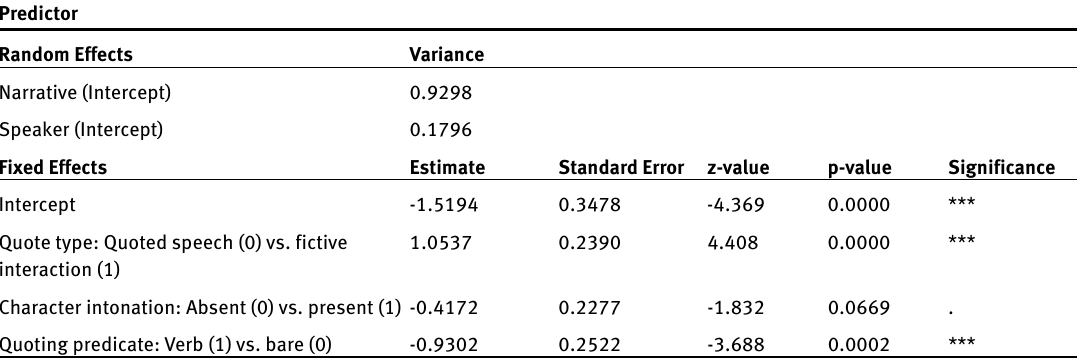
Table 9: The best generalized mixed-effects regression model for Quoted Monologues. Only predictors for the best-fit model are shown. Negative estimates indicate lower probability. Significance is indicated as follows: *** indicates p < 0.001, ** p < 0.01, * p < 0.05 and . p <